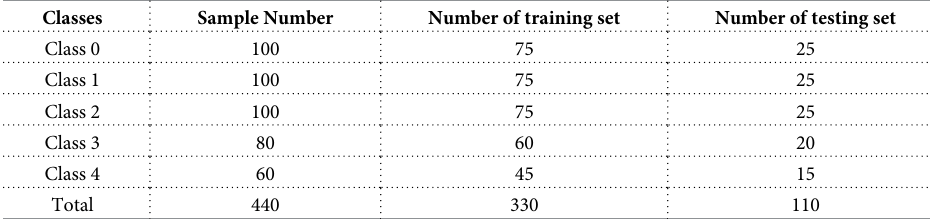
Table 5. Number of total samples, training set, and testing set in five classes.